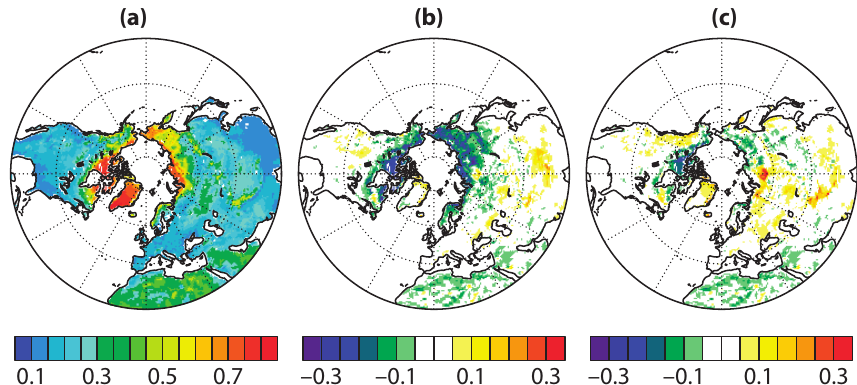
Figure 14. Mean observed Northern Hemisphere albedo during spring (MAM) derived from MODIS (a) , difference between ERA-Interim and MODIS (b) , and difference between ERA-Interim/Land and MODIS (c)